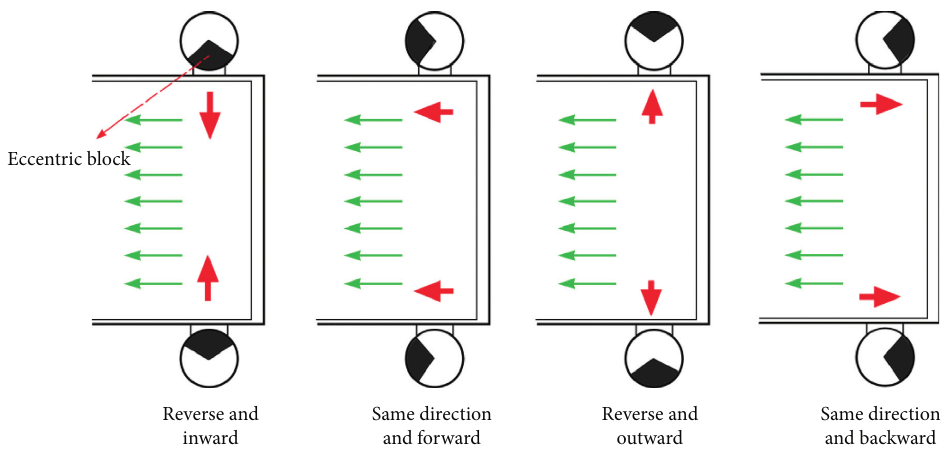
Figure 7: Exciting force directions at four special moments. Table 2: Material forces in different areas corresponding to the four exciting force